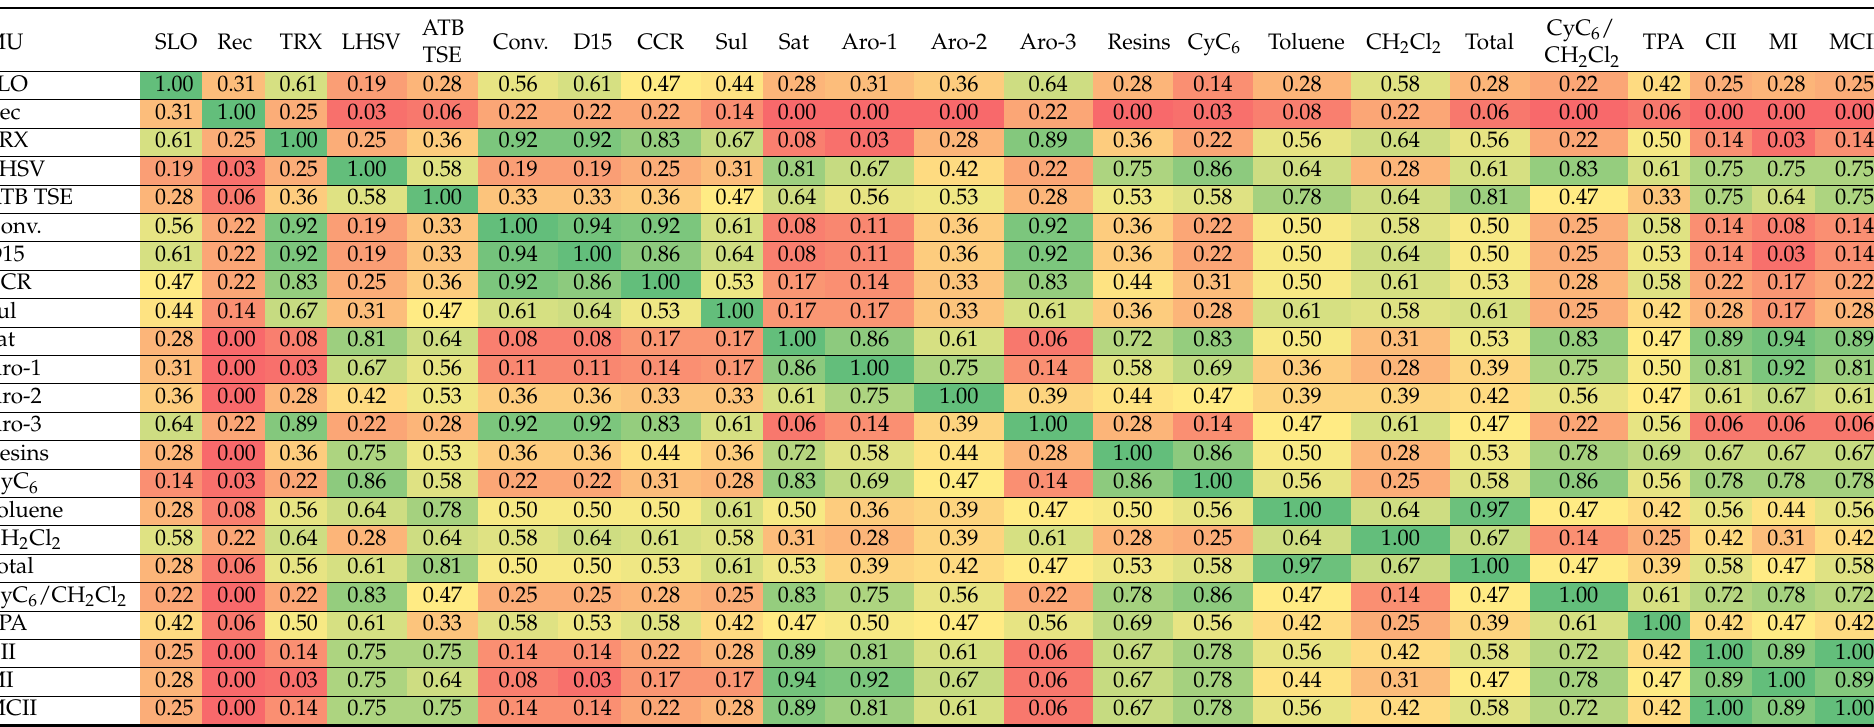
Table 3. µ -value of the ICrA evaluation of relations between bulk properties, SAR-AD characteristics of H-Oil VTB, and reaction severity. SLO = FCC slurry (%